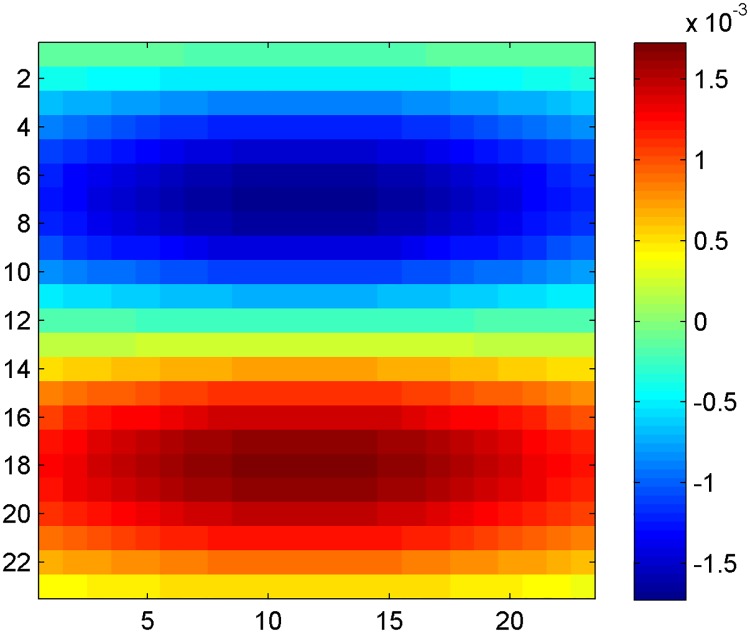
Gabor filter.Illustration of the 23 × 23 pixels Gabor filter of Eq (A-6).